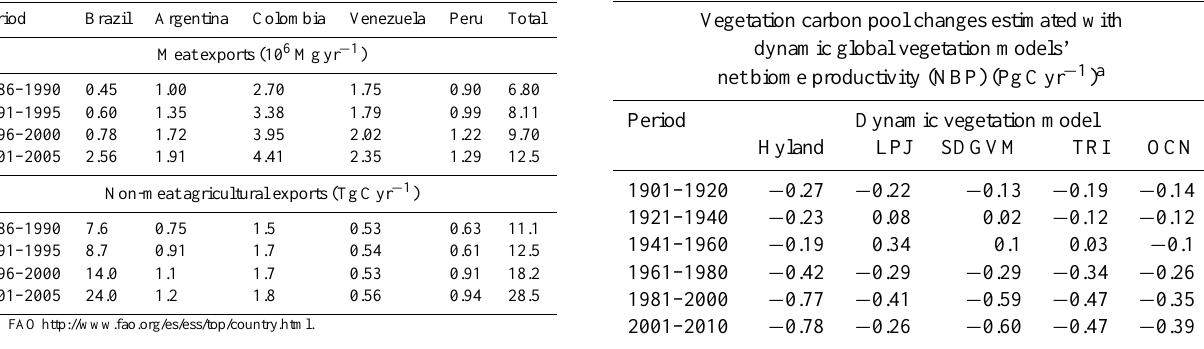
Table 10. Exports of Agricultural products a . Period